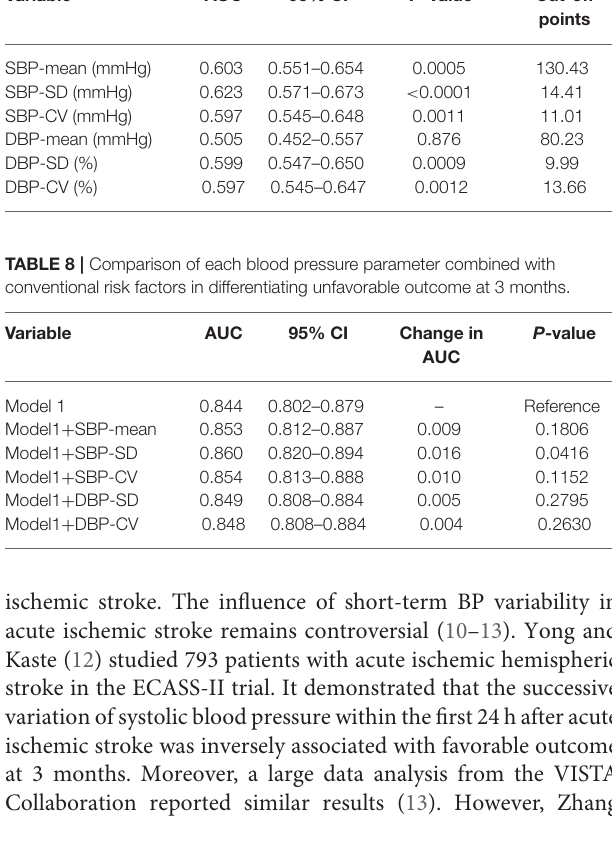
TABLE 7 | Blood pressure parameters for the prediction of unfavorable outcome at 3 months. Variable